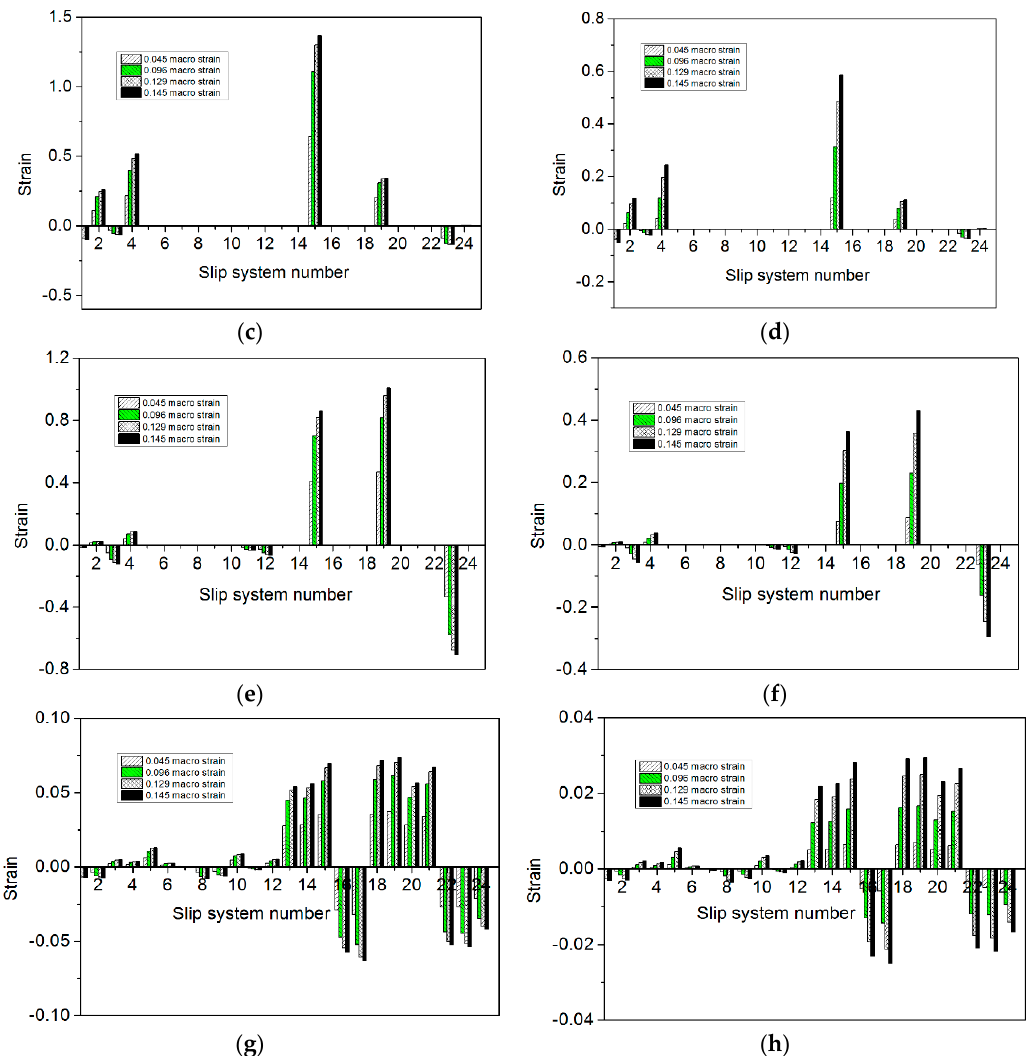
Figure 14. The strain of each slip system with different overall strains. ( a ) Ferrite strain of Rt ‐ C. ( b ) Martensite strain of Rt ‐ C. ( c ) Ferrite strain of {111} <112>. ( d ) Martensite strain of {111} <112>. ( e ) Ferrite strain of ~S. ( f ) Martensite strain of ~S. ( g ) The average ferrite strain for all grains. ( h ) The average martensite strain for all grains.